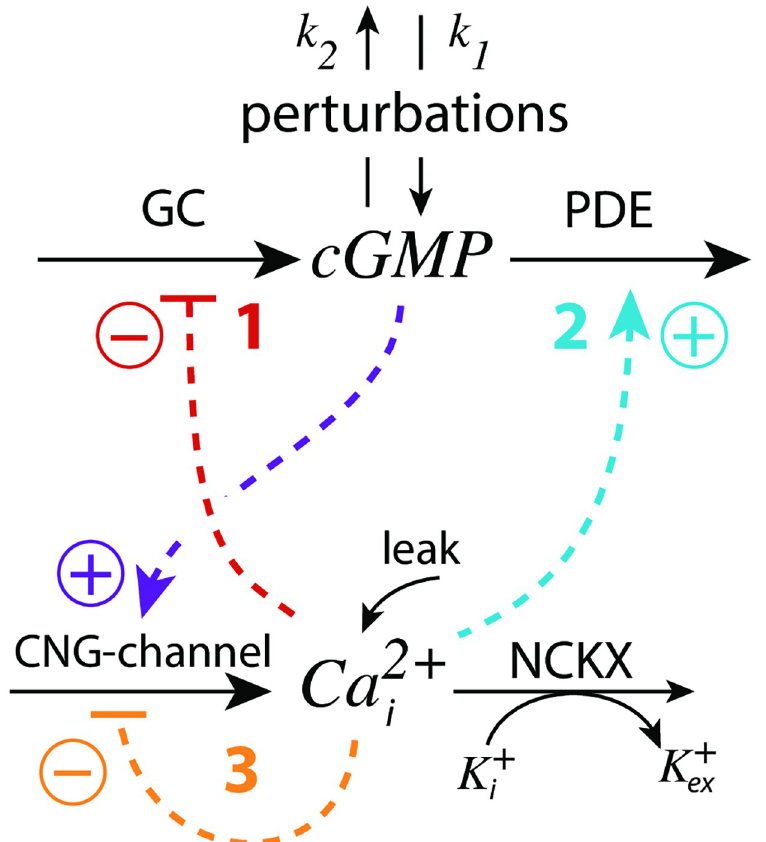
Fig 18. Schematic outline of the feedback loops 1–3 in the model (Fig 13). CNG: cyclic nucleotide-gated; GC: guanylate cyclase; PDE: phospho-diesterase; NCKX: potassium-dependent sodium-calcium exchangers (without the sodium